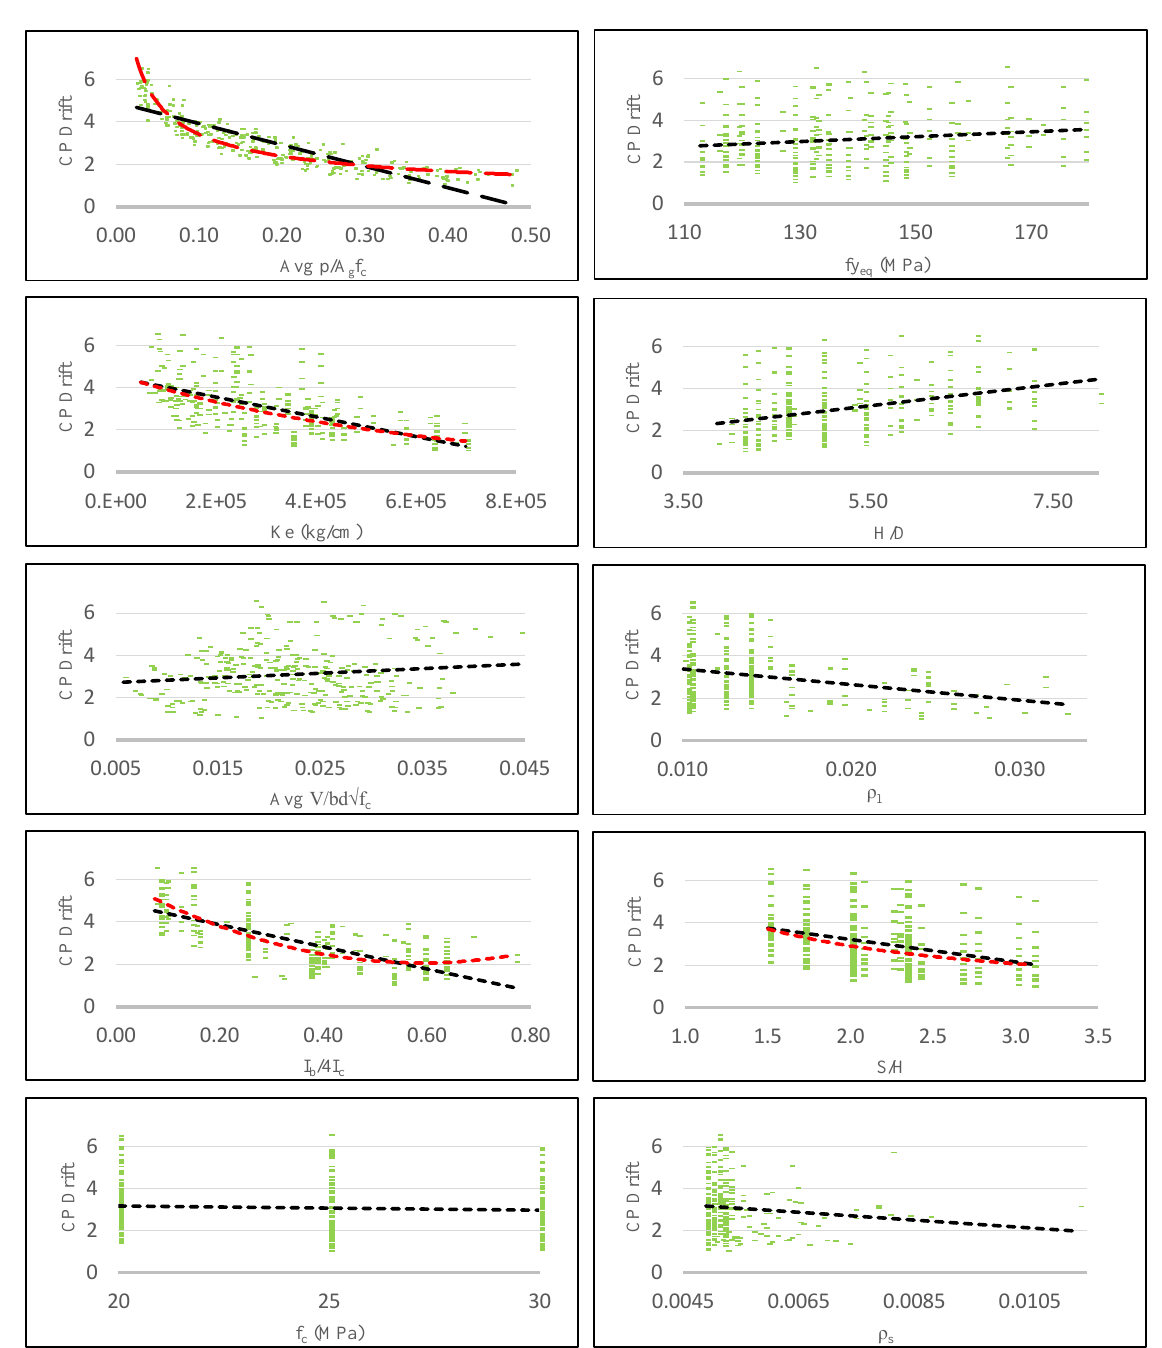
Figure 3. Linear and nonlinear trend of independent variables and the drift value at CP performance